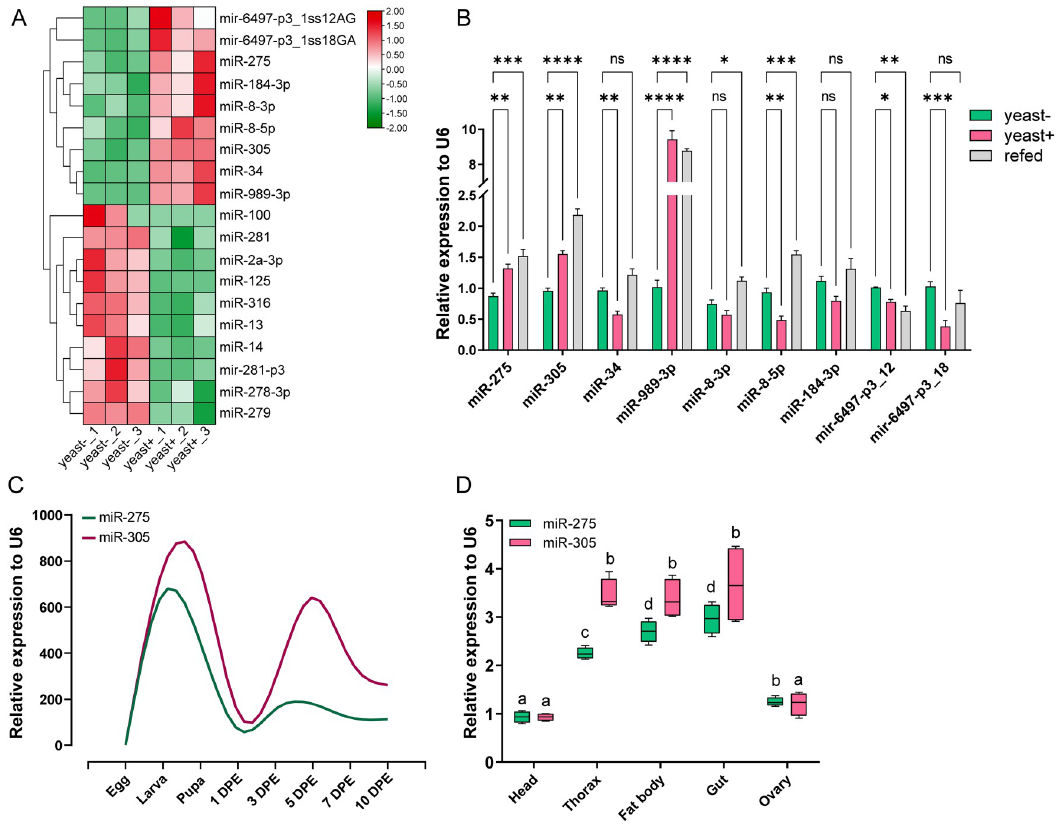
Fig 2. Identification of miRNAs potentially involved in energy metabolism in B . dorsalis . (A) Hierarchical clustering analysis of the differentially expressed miRNAs in response to dietary yeast stimulation. Heatmap showed two separated clades with up- regulated miRNAs in one clade and down-regulated miRNAs in the other clade. The color scale indicates the Log2-transformed expression values in the heatmap. (B) Expression levels of up-regulated miRNAs in the abdomens of B . dorsalis treated with three different dietary regimens, namely, yeast-free diet (yeast-), yeast-rich diet (yeast+), and 4-day yeast-free diet followed by 2-day yeast- rich diet (refed). Data are expressed as means ± SEM. ���� , P < 0.0001; ��� , P < 0.001; �� , P < 0.01. (C-D) Relative expression levels of miR-275 and miR-305 during the larvae-pupa-adult developmental stages (C) and different tissues isolated at 5 day post eclosion (DPE) of the adult female (D). The smooth curve was fitted using the LOWESS spline method with GraphPad Prism to visualize the dynamic expression of miRNA. Different lowercase letters above bars denote significant differences ( P < 0.05) according to Tukey’s test (one-way ANOVA).